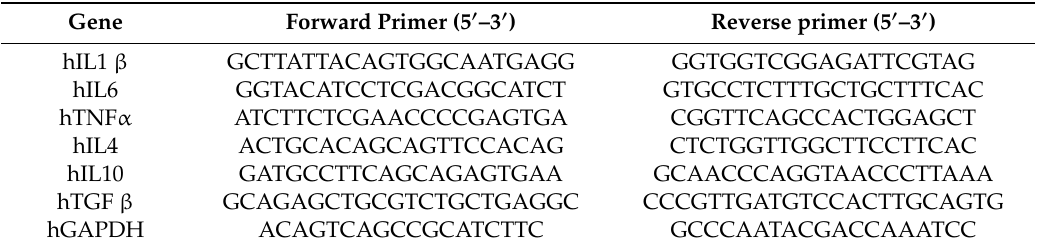
Table 5. The primers for PCR